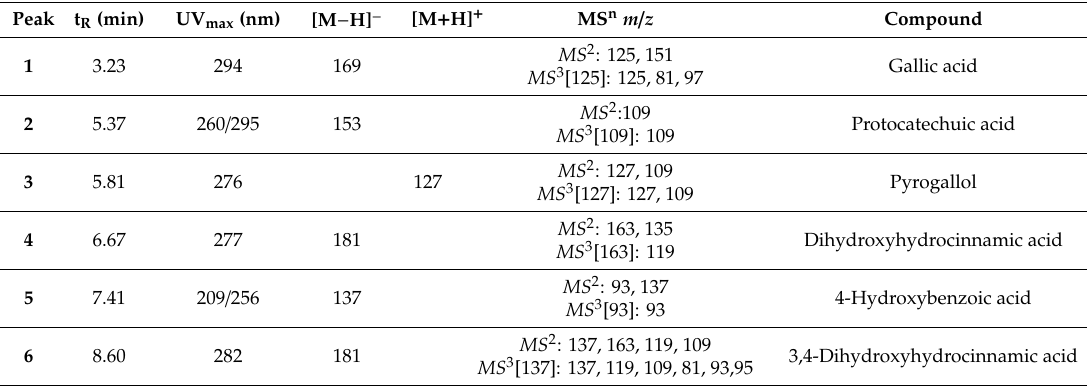
Table 2. LC-MS Identification of phenolic compounds in